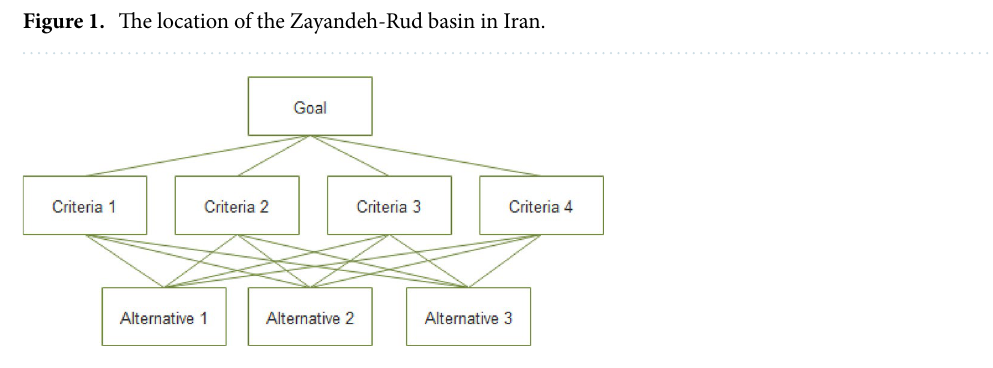
Figure 2. Goal, criteria, and alternatives in a generic hierarchical